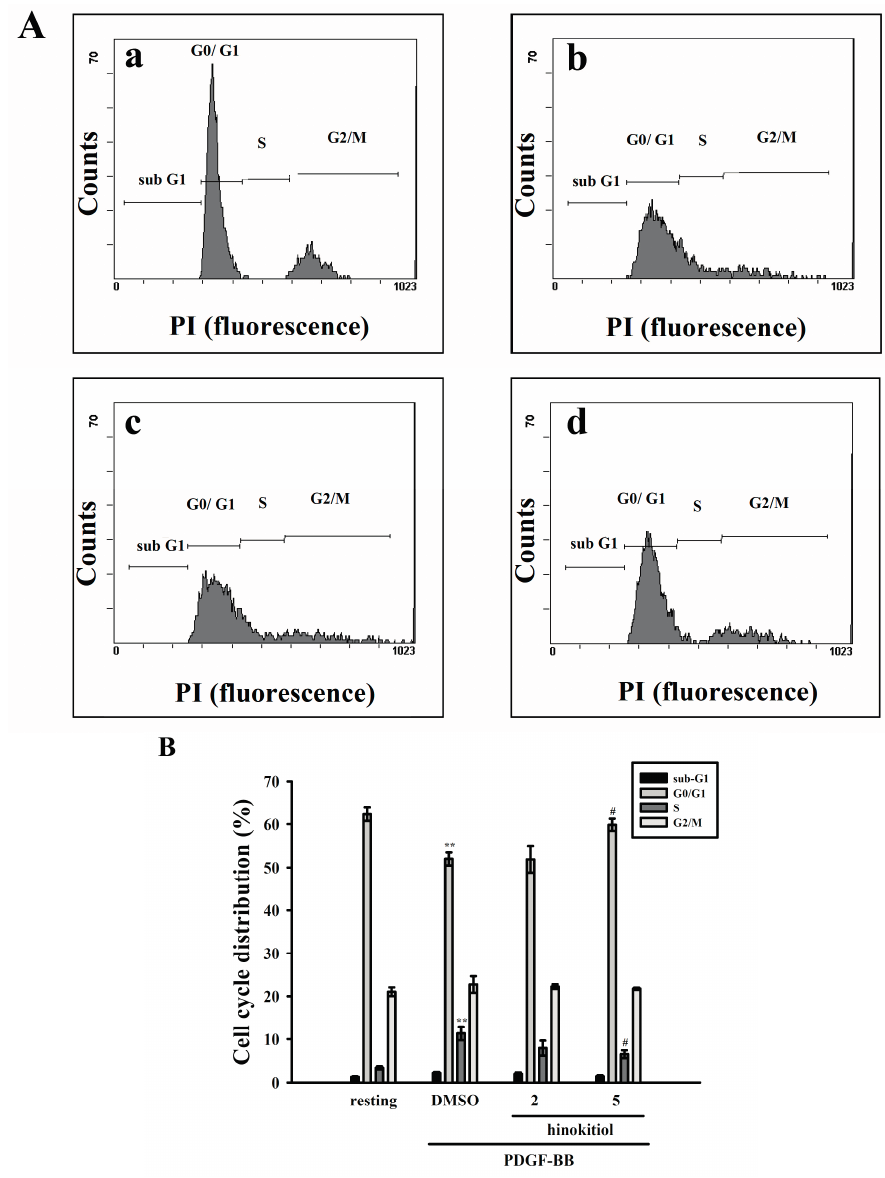
Figure 3. Effect of hinokitiol on PDGF-BB-induced cell cycle progression in VSMCs. ( A ) VSMCs were (graph a ) treated with PBS (resting) or pretreated with (graph b ) solvent control (0.1% DMSO) or (graph c ) 2 μ M or (graph d ) 5 μ M hinokitiol, followed by